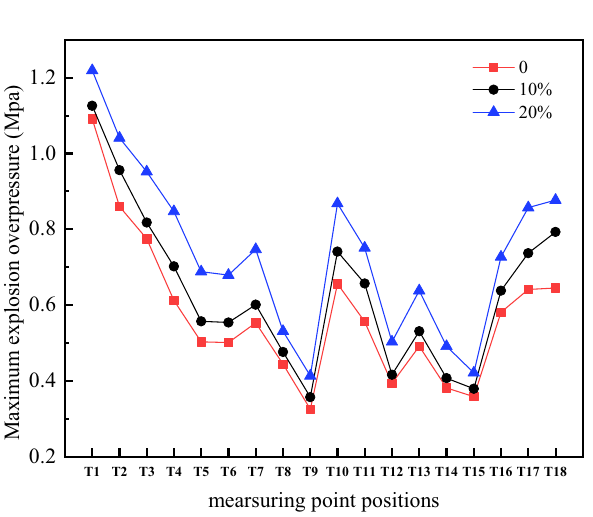
Figure 3. Maximum explosion overpressure of all measuring